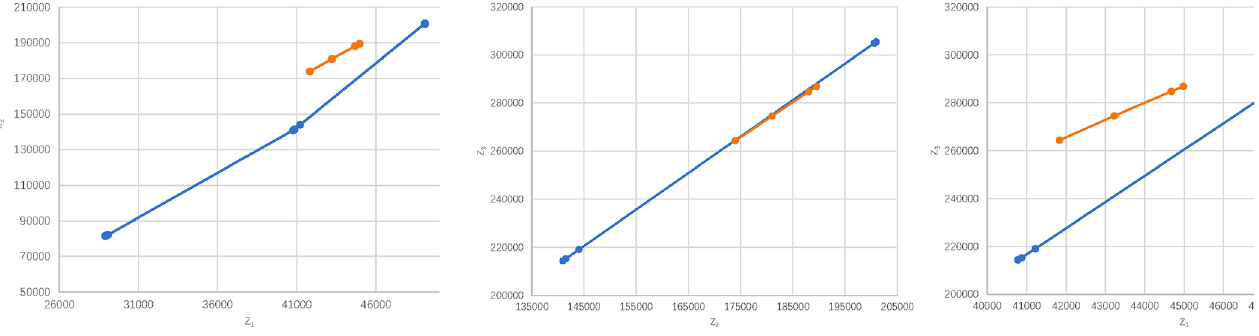
Fig 5. Pareto front for α = 0.5 of AUGMECON